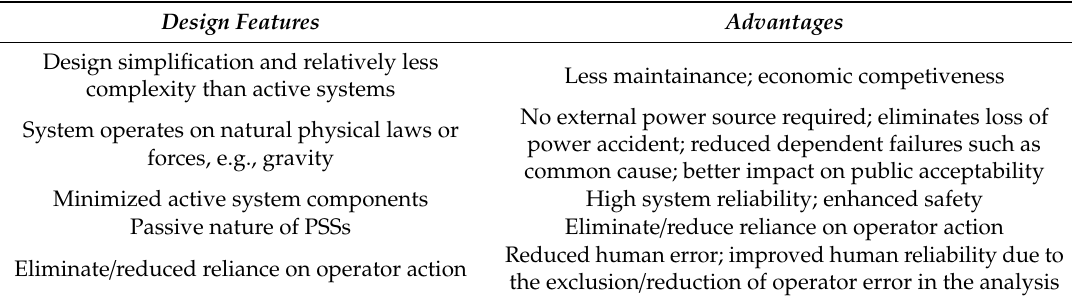
Table 3. Key advantages of passive safety